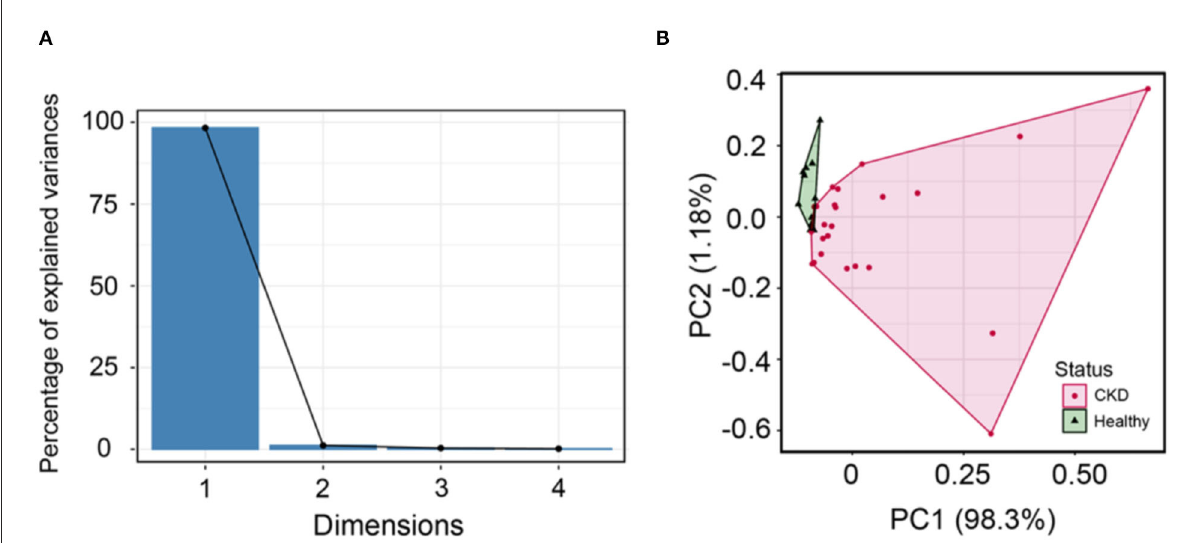
FIGURE6 (A) The scree plot shows dimensions and percentage of variance, as explained by each dimension (PC). (B) Principal component analysis can distinguish between normal age-matched cats (green) and CKD (pink) detected when using cluster analysis.